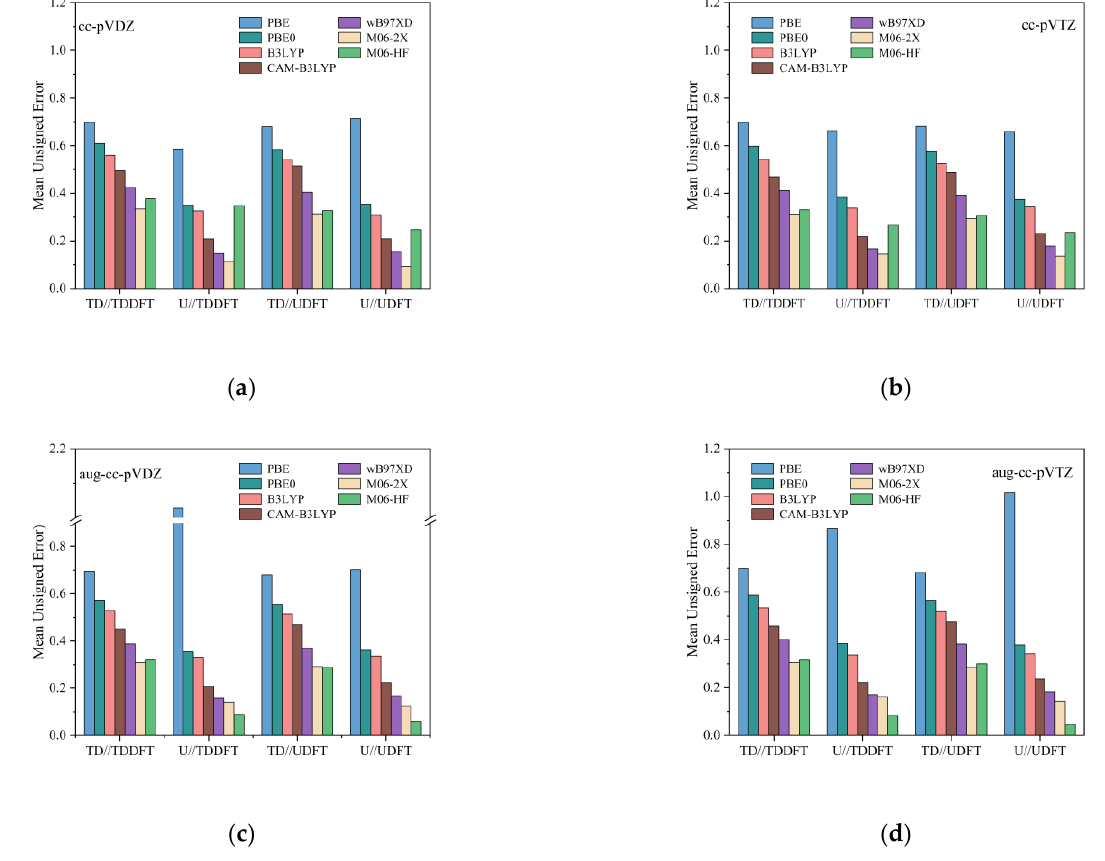
Figure 1. The MUE values obtained by different basis sets under the same phosphorescence energy calculation method and functionals. ( a ), ( b ), ( c ), and ( d ) represent the results obtained with the basis set of cc-pVDZ, cc-pVTZ, aug-cc-pVDZ, and aug-cc-pVTZ, respectively. Table 3. The energy differences ΔE (in eV ) relative to the CC2 for the phosphorescence energy of AQs, as calculated by U//UDFT with the different functionals (PBE, PBE0, B3LYP, CAM−B3LYP,